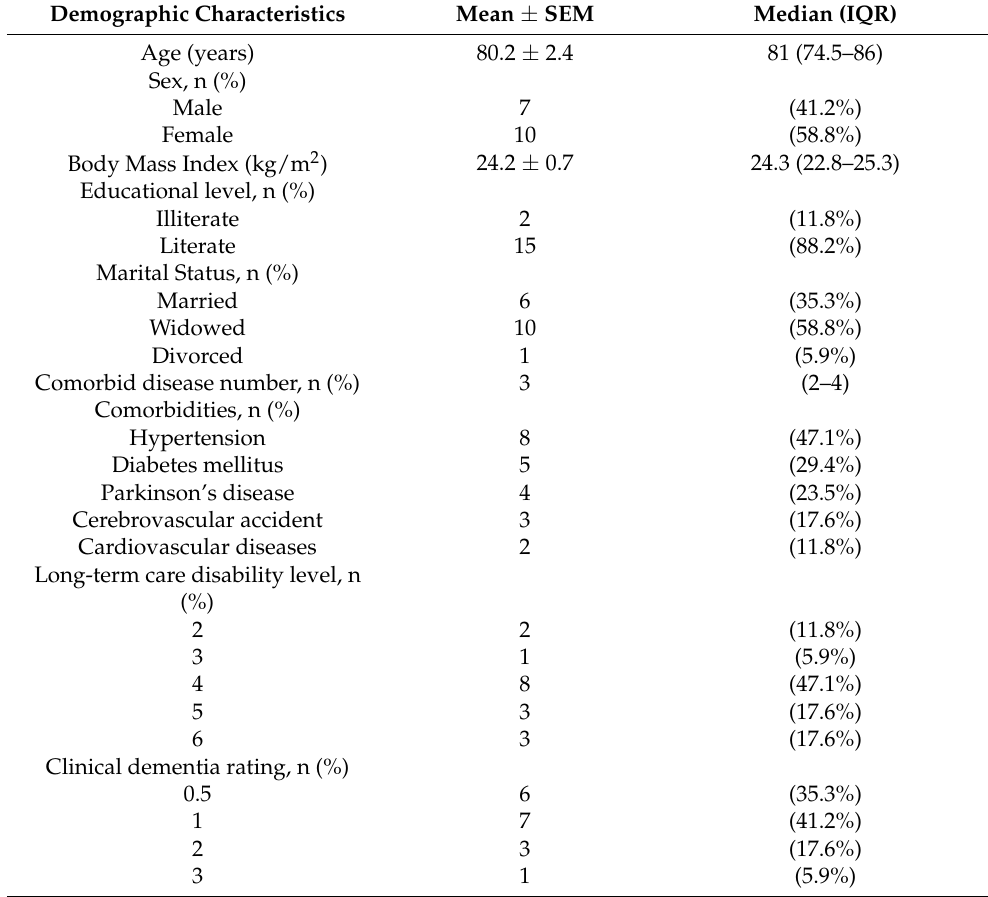
Table 1. Baseline characteristics of the